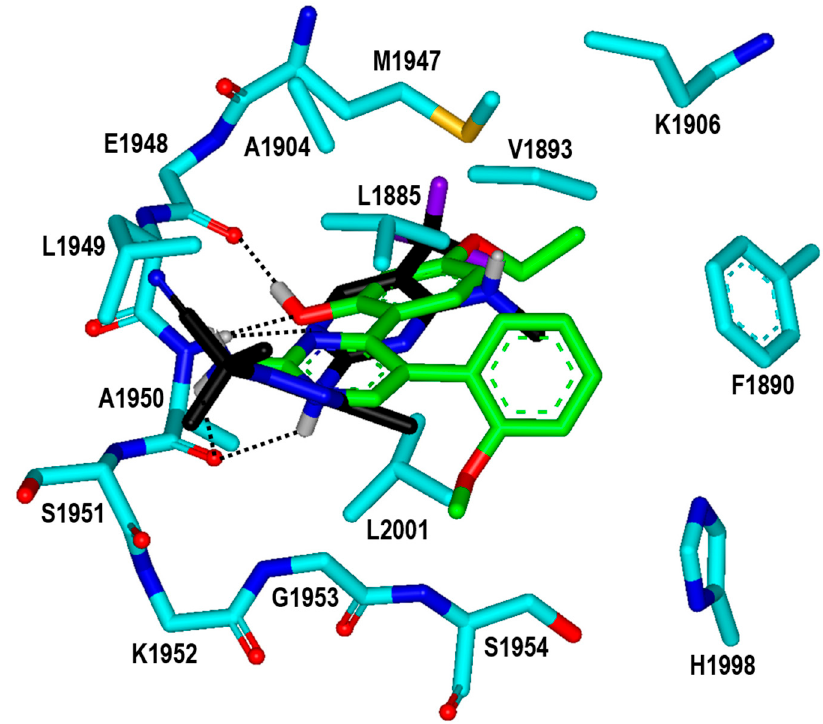
Figure 8. Calculated binding mode of Inhibitor 2n in the ATP-binding site of the G2019S mutant of LRRK2 in comparison with that of DNL-151. The carbon atoms of the protein, Inhibitor 2n , and DNL-151 are indicated in cyan, green, and black, respectively. Each dotted line indicates a hydrogen